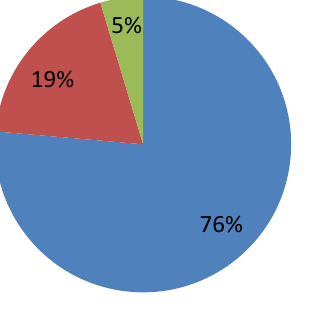
Figure 4. Mobile users market share of three telecom operators in China December